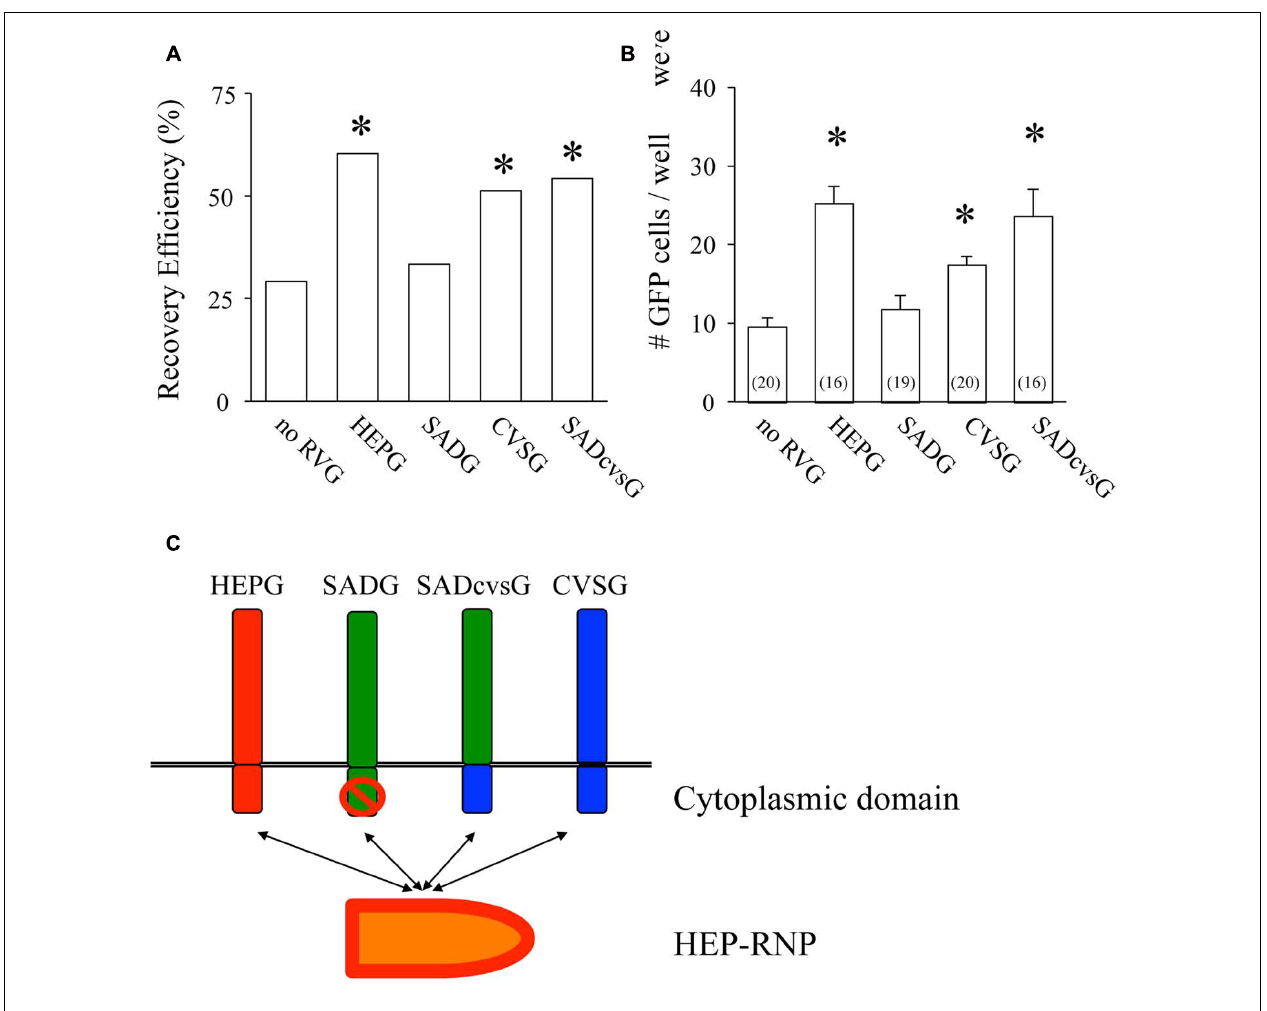
wells with GFP positive cells. (C) Schematic of the interaction between RVG and HEP-ribonucleoprotein complex (RNP). HEP-RNP can interact with the cytoplasmic domains of HEPG and CVSG but not of SADG. A chimeric RVG, SADcvsG, restores its interaction to HEP-RNP. Asterisks indicate significant differences from the absence of RVG ( A,B